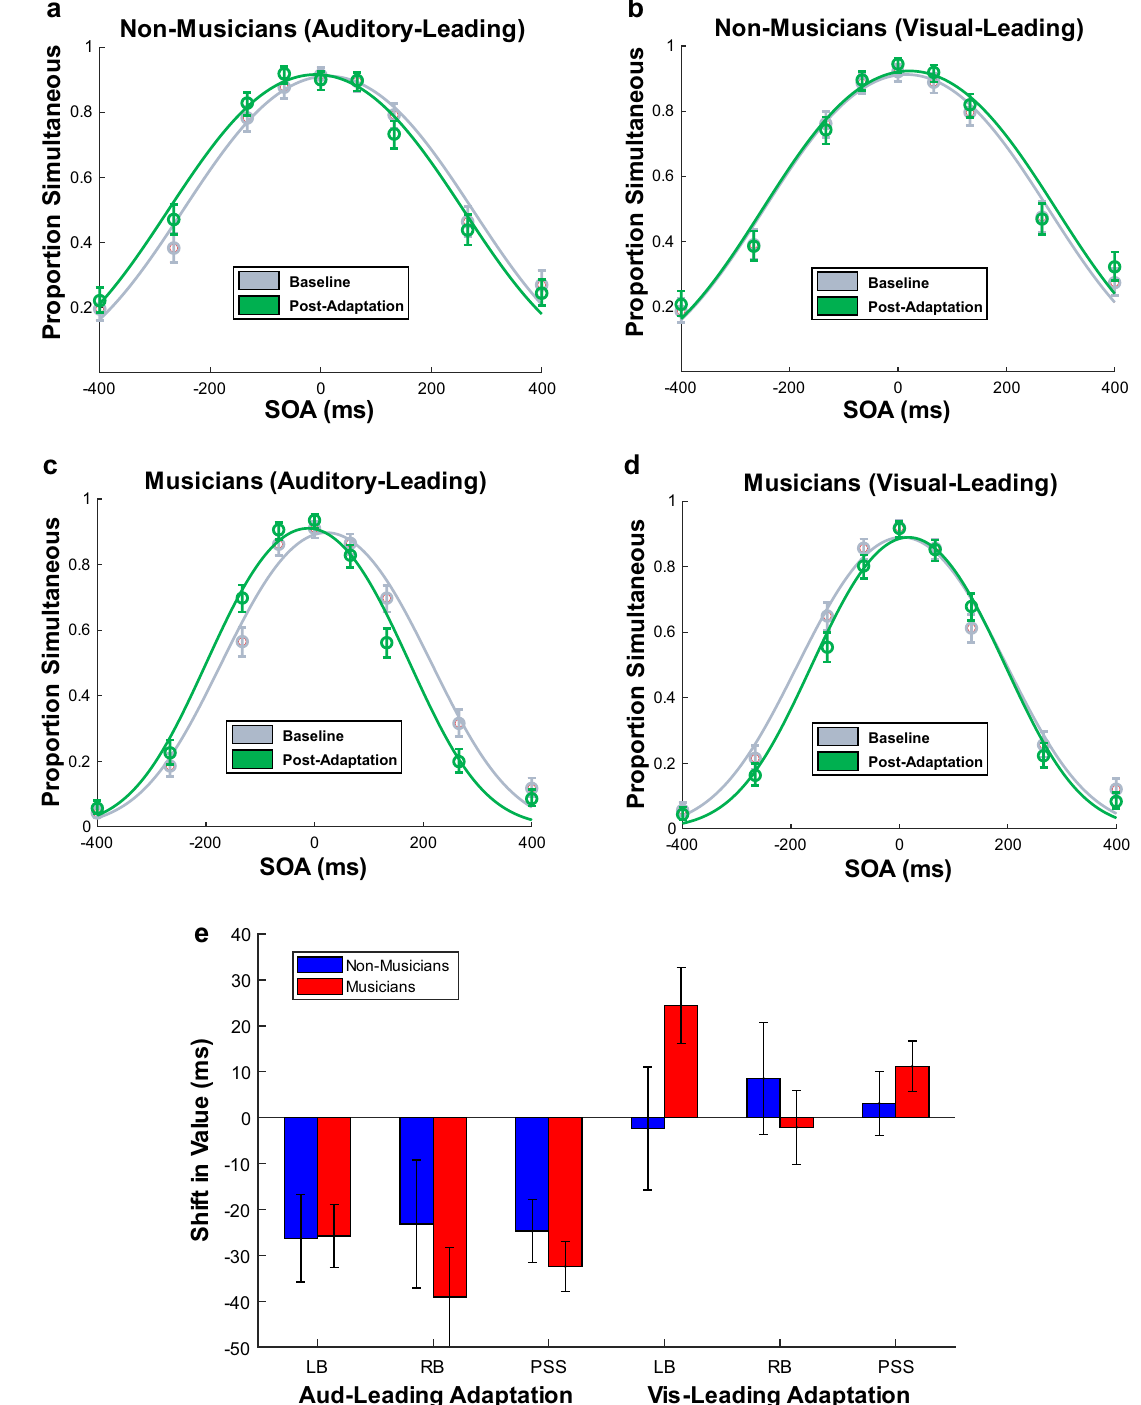
Figure 3. Group observer model fits depicting cumulative recalibration following auditory-leading and visual-leading adaptation. ( a ) Auditory-leading adaptation experienced by non-musicians. ( b ) Visual-leading adaptation experienced by non-musicians. ( c ) Auditory-leading adaptation experienced by musicians. ( d ) Visual-leading adaptation experienced by musicians. ( e ) Bar plot of parameter values showing that for both directions of cumulative recalibration, there were no significant group differences in the shift of the left boundary (LB), the right boundary (RB), or in the average of the boundaries (PSS). Furthermore, in both groups, only auditory-leading adaptation produced significant recalibration effects. Error bars show one standard error of the